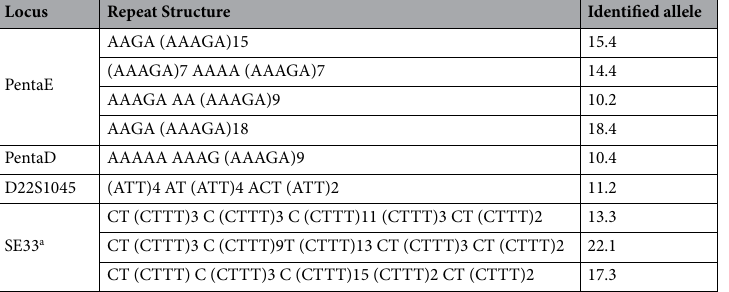
Locus Repeat Structure Identified